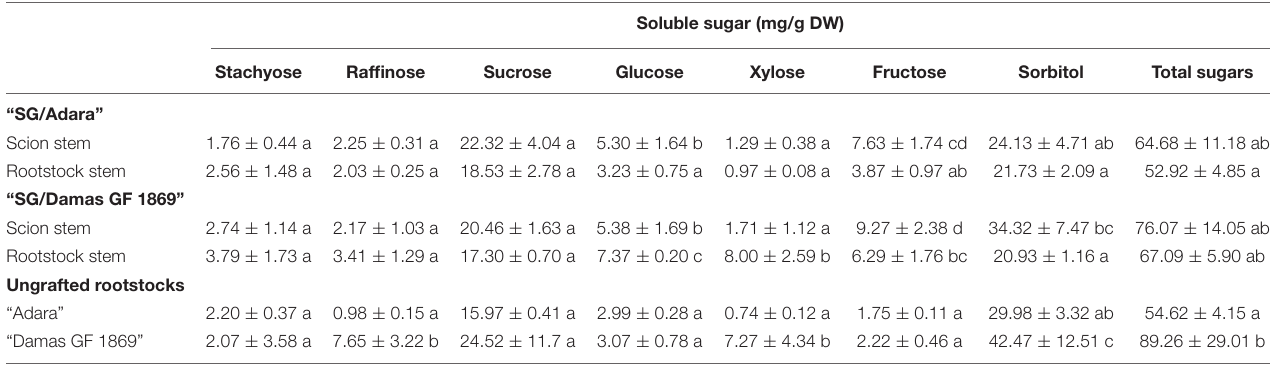
TABLE 2A | Stem soluble sugars (mg/g DW) in the bark from the scion and rootstock of the compatible (“SG/Adara”) and incompatible (“SG/Damas GF 1869”) graft-combinations, and ungrafted rootstocks at the leaf fall period. Soluble sugar (mg/g DW)